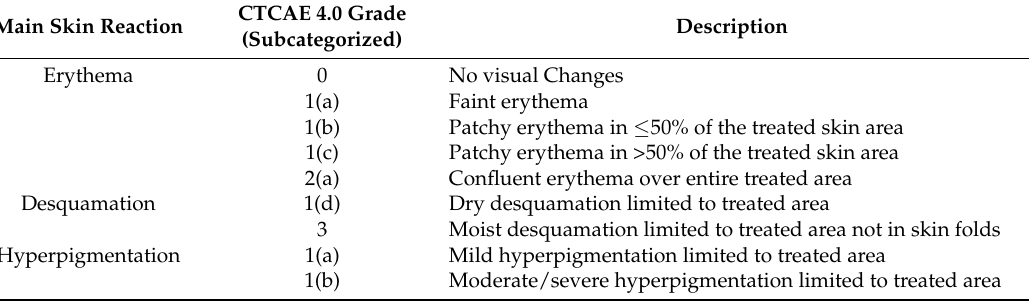
Table 1. Table 1 . Skin toxicity scale.